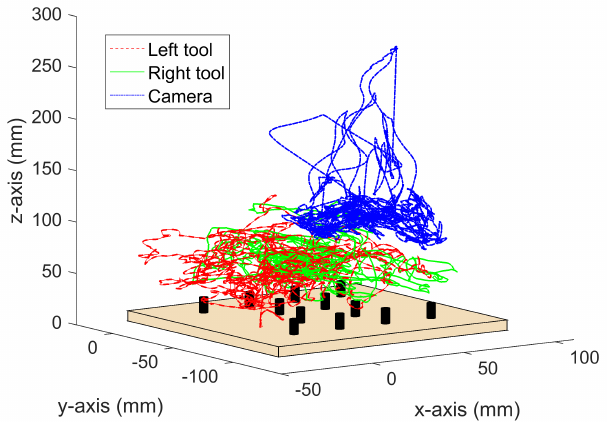
Figure 8. Tools and camera trajectories during the pick-and-place task